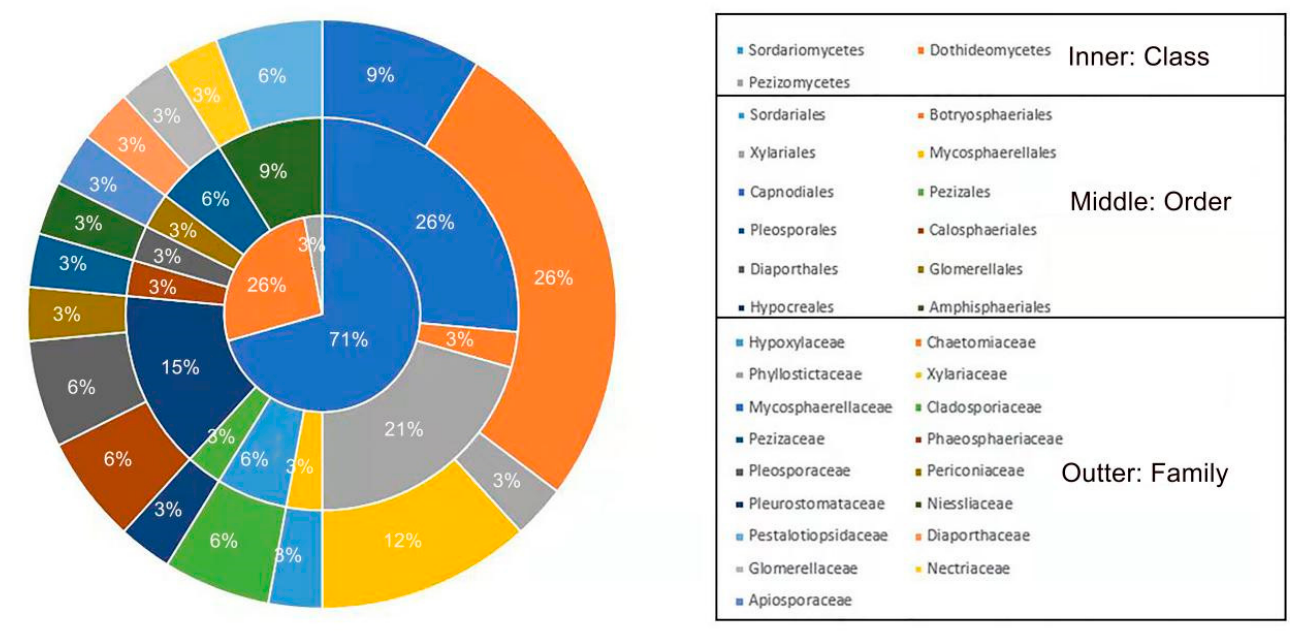
Figure 2. The left side shows the phylogram generated from maximum likelihood analysis based on an ITS sequence dataset. The tree is rooted with Candelariella blastidiata (LE ‐ L11031). The ML boot ‐ strap support values equal to or greater than 60% are shown at the nodes. Type strains are indicated in bold. The right - side images show all the endophytic fungi cultures that were grown on PDA at room temperature for two weeks and their culture collection numbers are written at the bottom of the culture image.